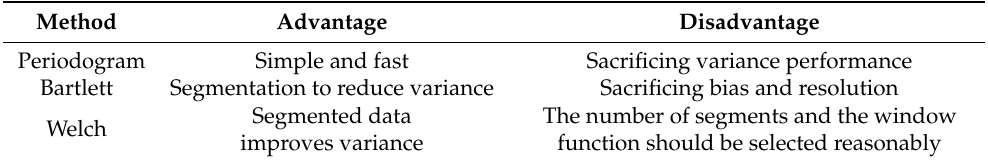
Table 3. Comparison of power spectrum estimation